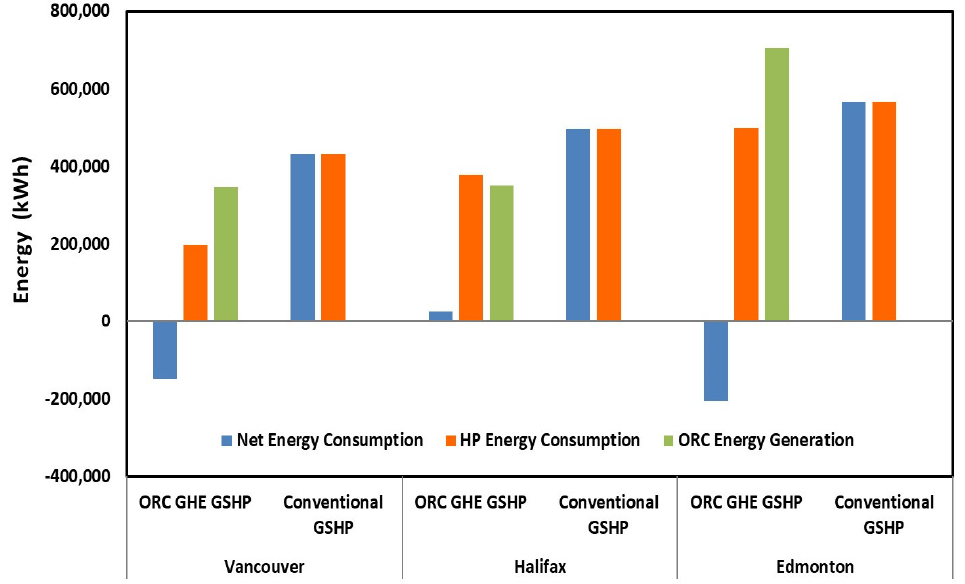
Figure 13. Average energy consumption during the 20-year period for each city and system.